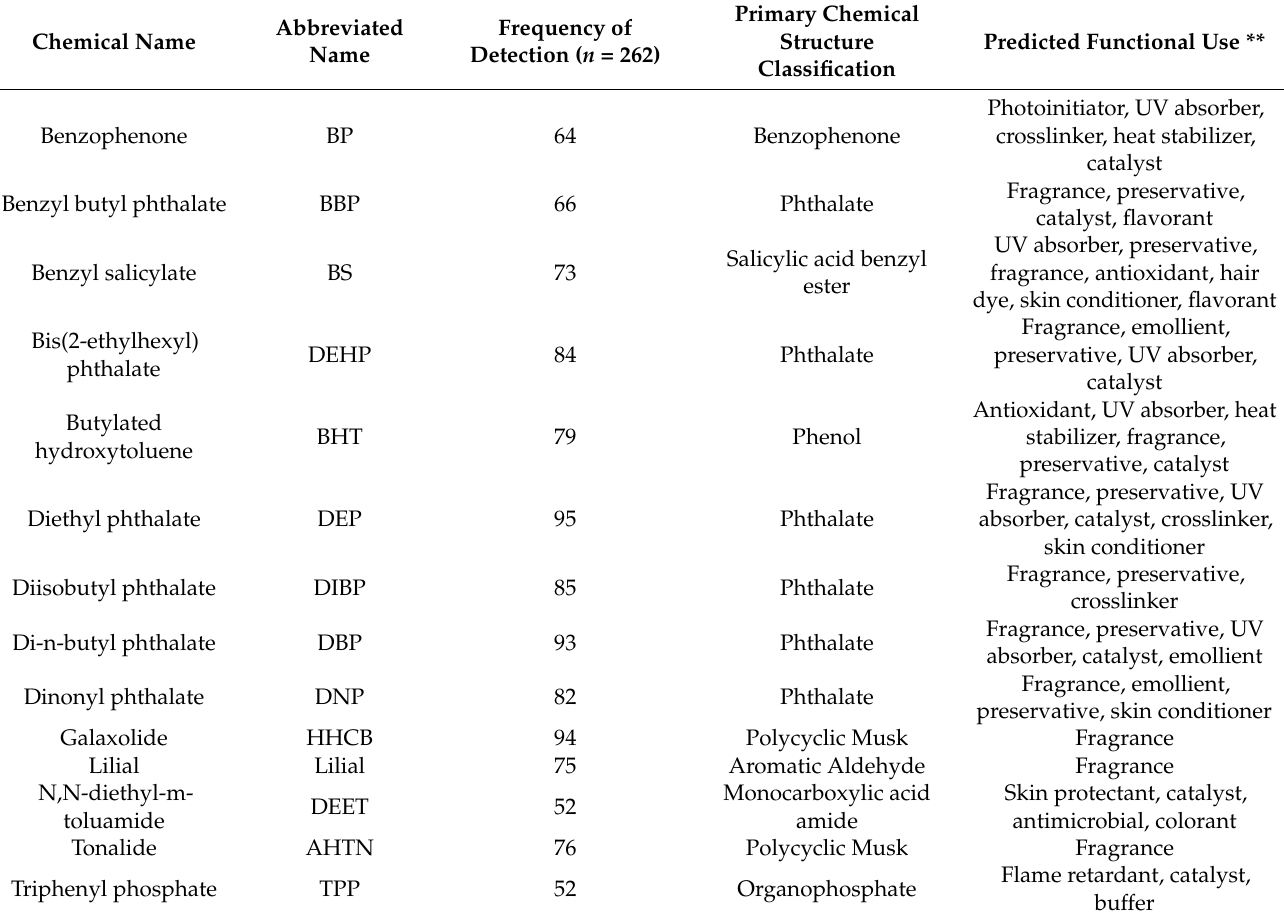
Table 1. Primary chemical structure classification and predicted functional use of each of the G14 chemicals. ** = Predicted functional use categories as determined by quantitative structure-use relationship (QSUR) models. Data was compiled and collected from the USEPA CompTox Chemicals Dashboard with data from Phillips, et al., 2017 [4]. Functional use categories with probability ≥ 0.3 are listed in order of highest to lowest predicted